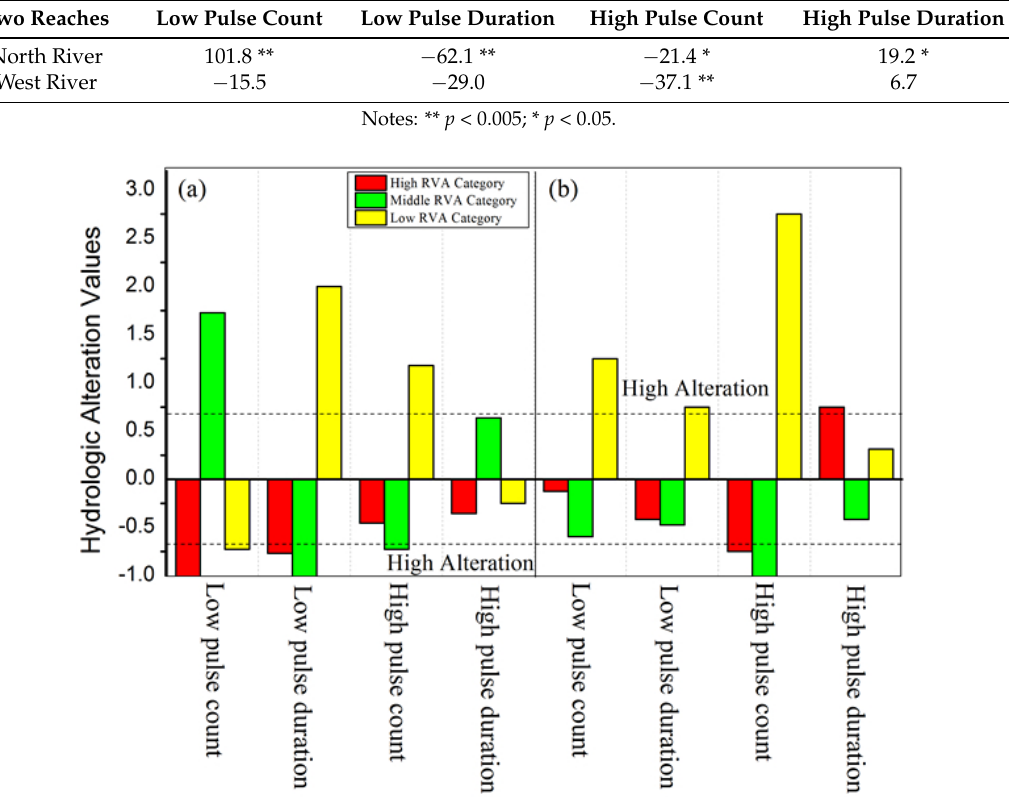
Figure 8. Hydrologic alteration frequency and duration of high and low pulses in the JRW based on RVA method. ( a ) North River reach; ( b ) West River reach.